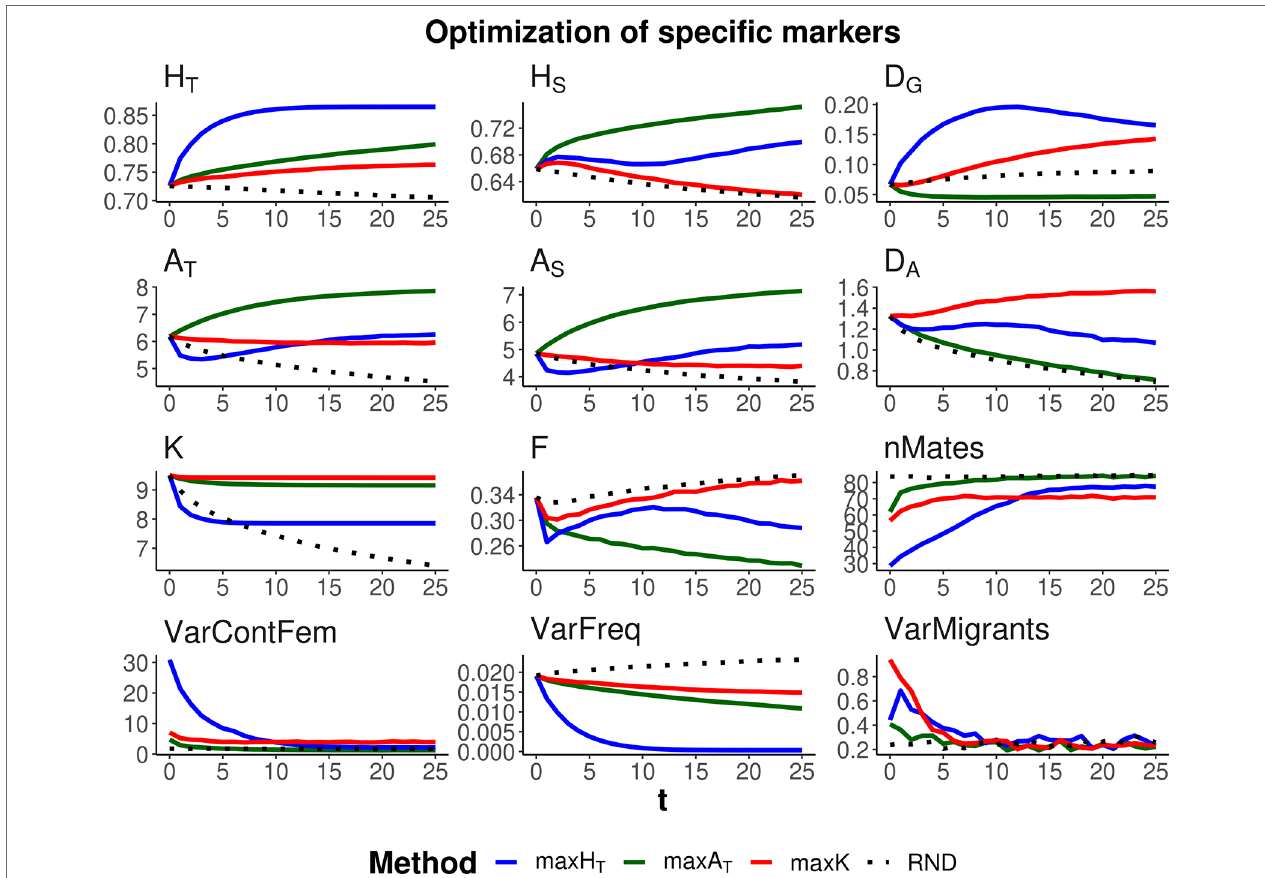
FIGURE 2 | Changes in different diversity parameters over generations ( t ) in a subdivided population subjected to three optimization methods, maxH T (blue line), maxA T (green line), and maxK (red line), and an unmanaged control (RND, dotted black line). Optimization was made for a particular set of loci (12 multiallelic single- nucleotide polymorphism haplotype markers). In the case of maxH T and maxA T , a between-population weighting factor of λ = 1 ( i.e., equal weight for within- and between-subpopulation components of diversity) was assumed. One migrant per subpopulation and generation was considered in the optimizations. Statistics measured in the managed markers: total heterozygosity ( H T ) and its within- and between-subpopulation components ( H S and D G ); total allelic diversity ( A T ) and its within- and between-subpopulation components ( A S and D A ); total number of alleles in the population ( K ); average coefficient of molecular inbreeding of individuals ( F ); number of pairing mates involved in the different procedures (nMates); variance of the contribution from female parents to progeny (varContFem); variance of allelic frequencies with loci (VarFreq); and variance of the number of migrants per subpopulation (VarMigrants). Standard errors for means are lower than 0.01 (allelic measures), 0.001 (heterozygosity measures), and 0.002 ( F